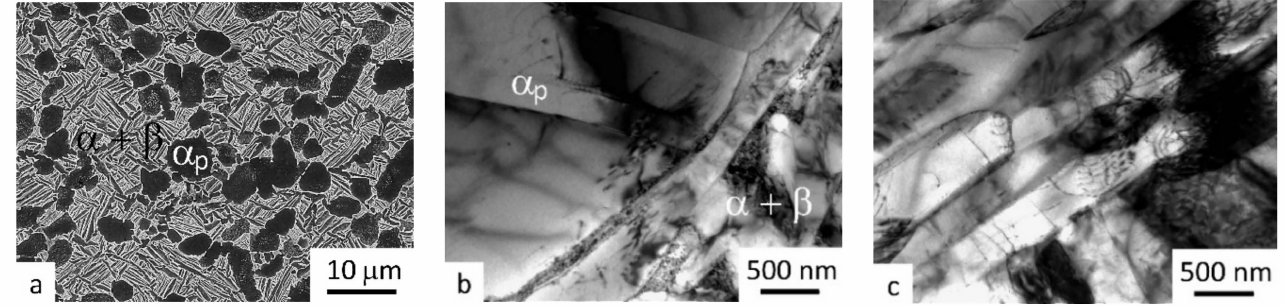
Figure 2. Microstructure images for the Ti-6Al-4V alloy samples after the standard HT: ( a ) general view of the microstructure taken by SEM, ( b ) TEM image of the primary α -phase, ( c ) lamellar structure in the two-phase region.